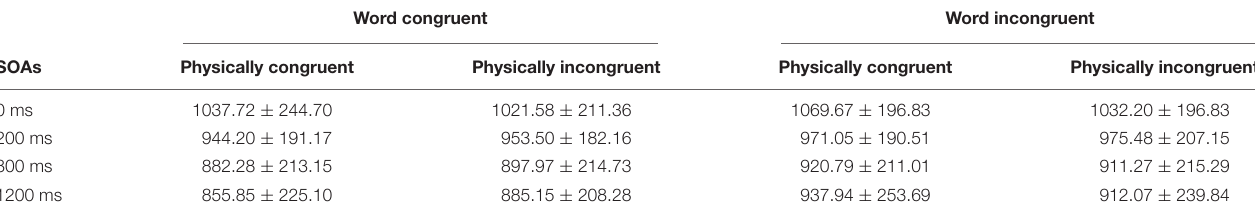
TABLE 1 | Response time (ms) of parity judgment task ( M ± SD